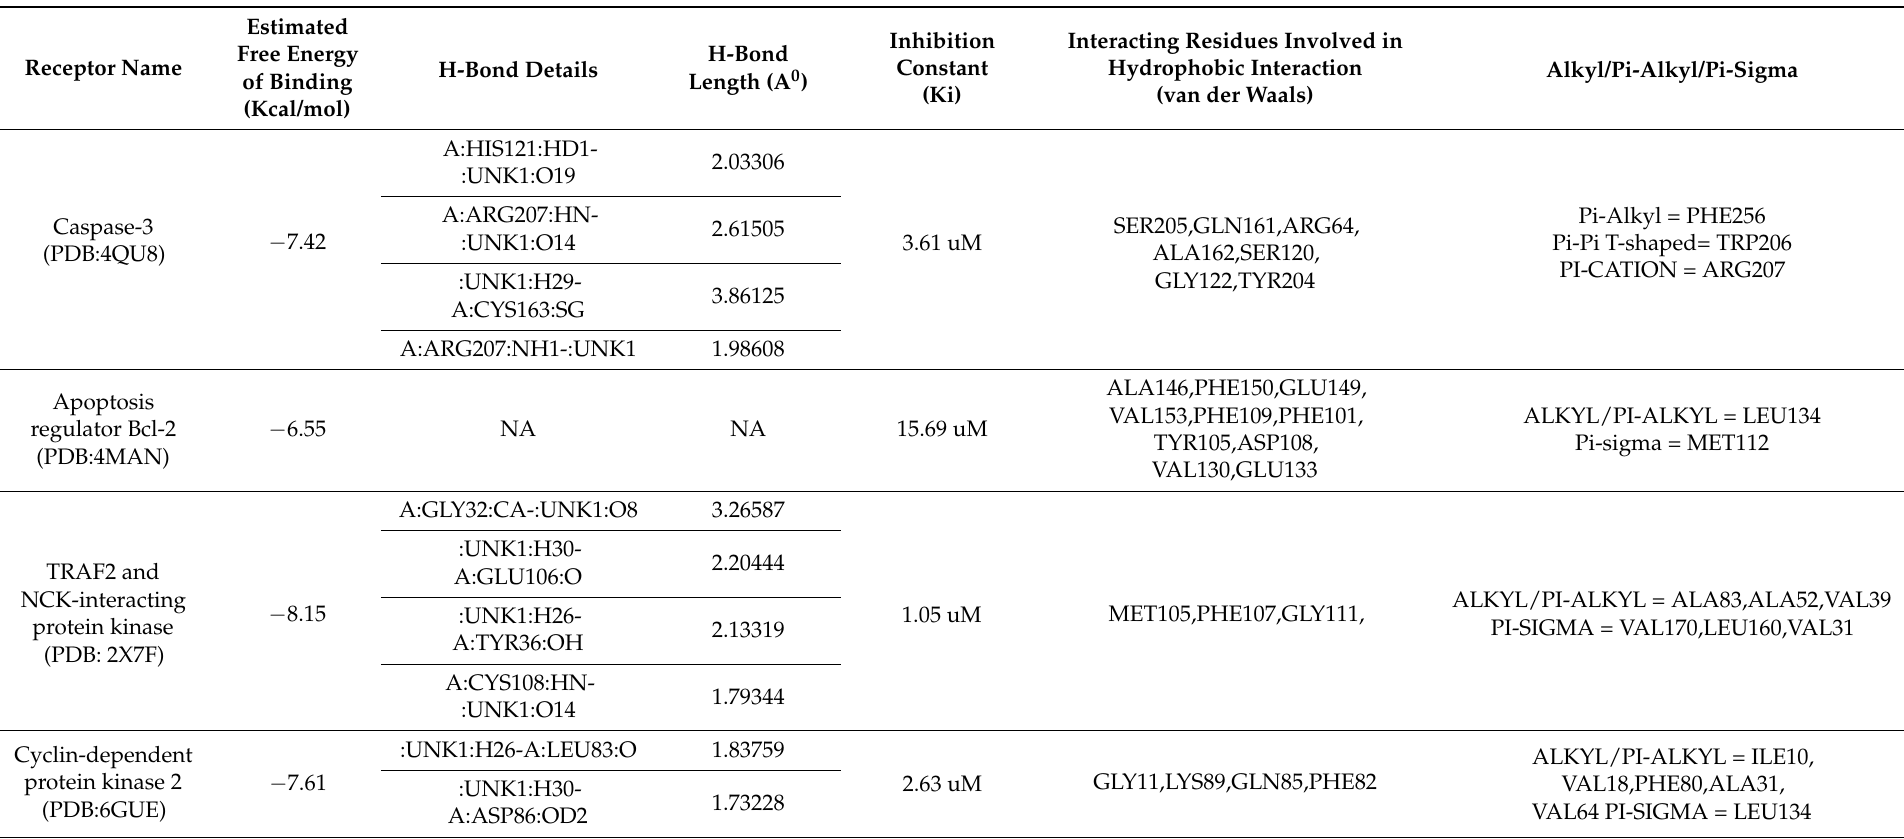
Table 1. Showing docking results of emodin with receptor molecules caspase-3, apoptosis regulator Bcl-2, TRAF2 and NCK-interacting protein kinase and cyclin-dependent protein kinase